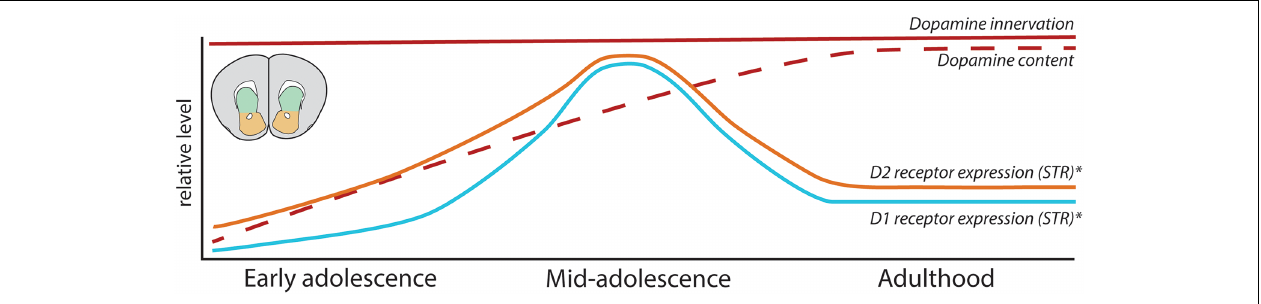
FIGURE 5 | Development of mesolimbic dopamine connectivity and function in the adolescent striatum. Summary of maturational changes in DA connectivity in the STR across adolescence. ∗ Indicates that these findings are sex-dependent, with this pattern of receptor overexpression and pruning only seen in male